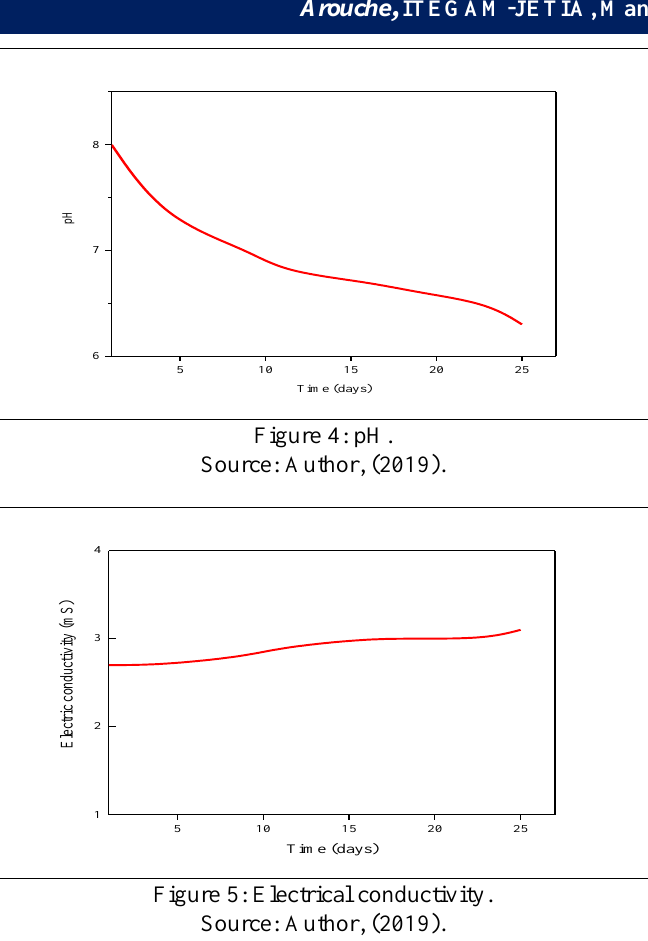
Figure 5: Electrical conductivity.